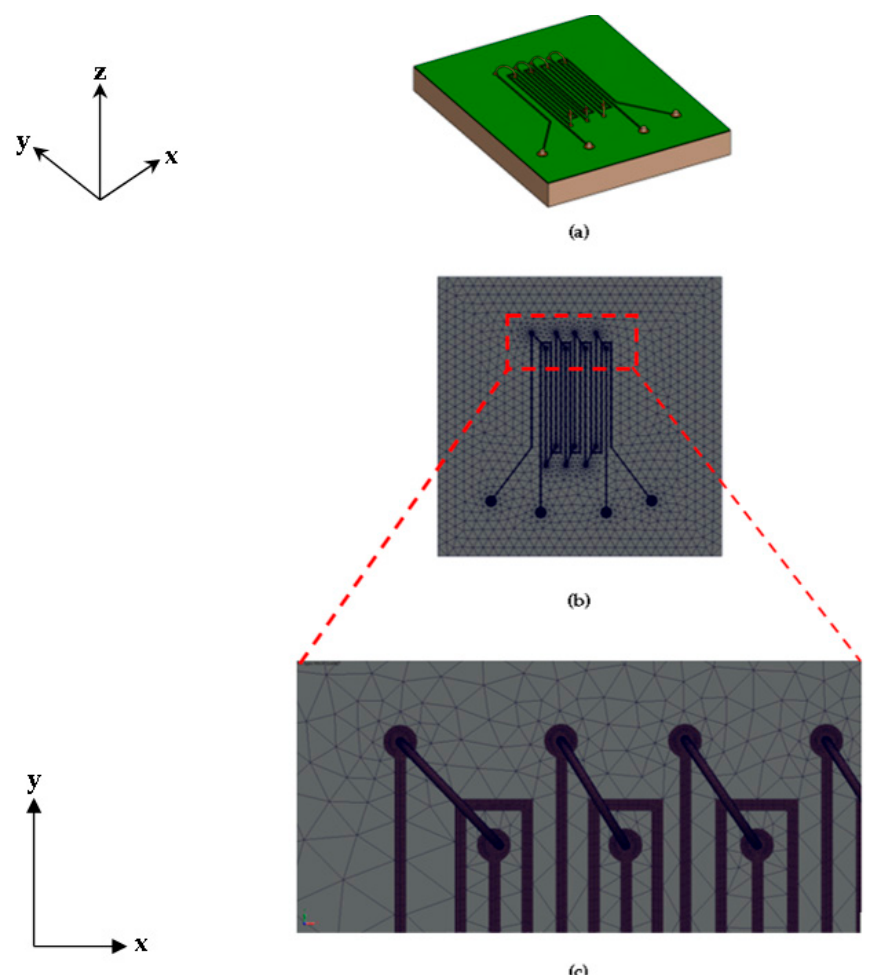
Figure 4. Computational model of the electronic chip and copper base for the heat dissipation analysis: ( a ) CAD model, ( b ) meshed model, and ( c ) close view of electrode meshing.